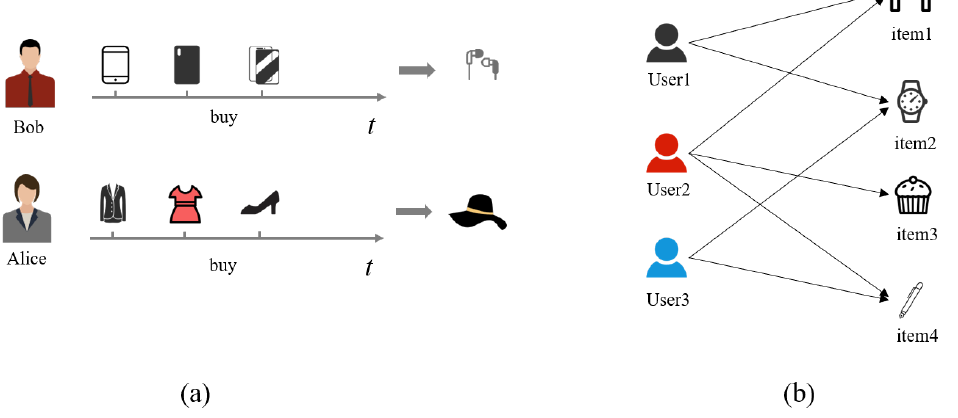
Figure 1. ( a ) Illustration of two user interaction sequences: Bob buys a cell phone, a phone case, a phone film, and a mobile earphone; Alice buys a suit, a dress, a shoe, and a hat, successively. ( b ) A toy example of an interaction network containing three users and four items. Each arrow represents an interaction from a user to an item. Each interaction is associated with a timestamp t and a feature vector f (such as the feature of the